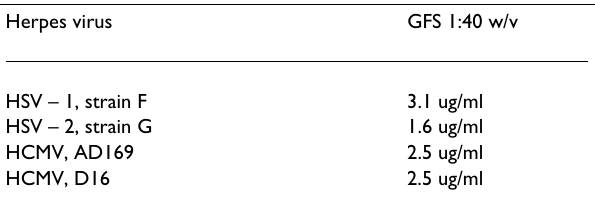
Table 3: IC50 for GFS whole extract as measured by infectivity of HSVI, HSV2 and HCMV (human cytomegalovirus) in human fibroblasts.